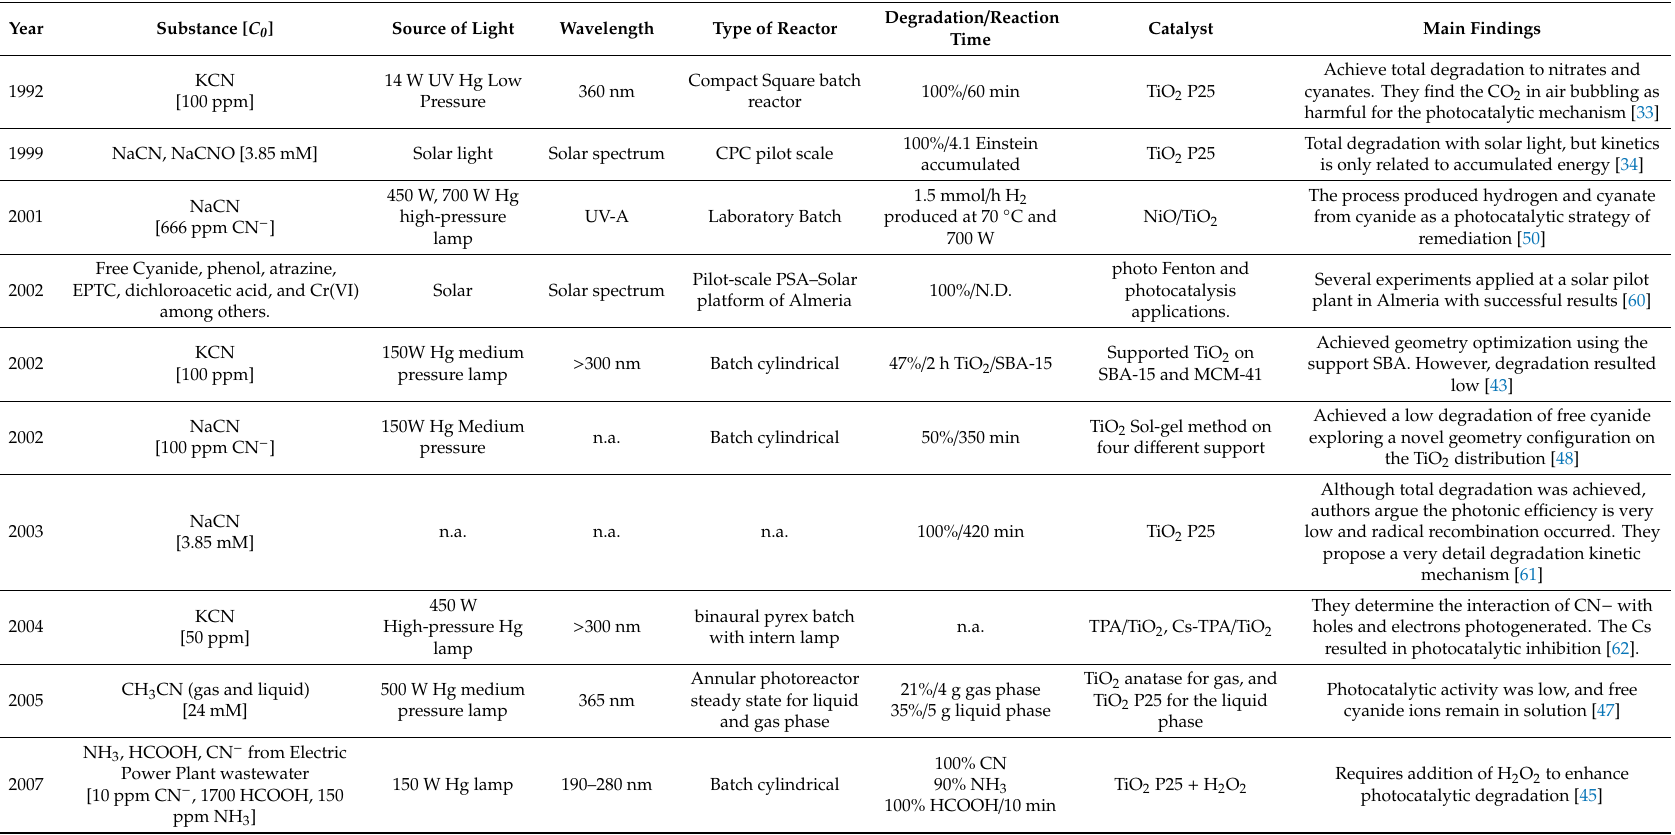
Table 2. Photocatalytic treatments applied to free cyanide